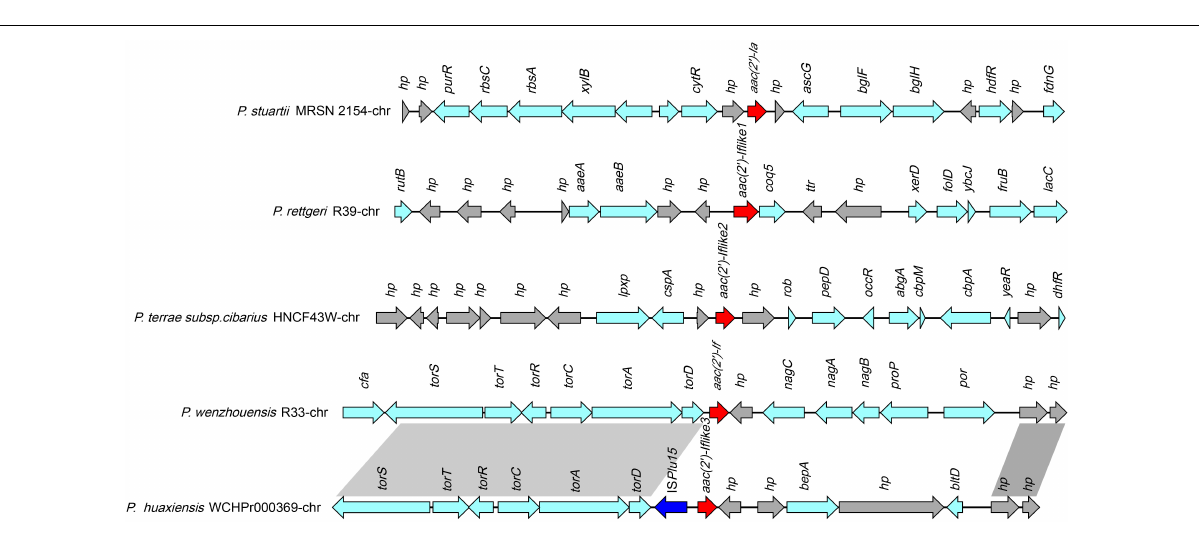
FIGURE 4 | Expression levels of aac(2 (cid:48) )-If treated or untreated with 32 µ g/mL ribostamycin (a) , 1 µ g/mL neomycin (b) , and 0.25 µ g/mL gentamicin (c) . Bars represent means ± standard errors and experiments were performed in triplicate. ∗∗∗ Presents significant difference, P < 0.001.